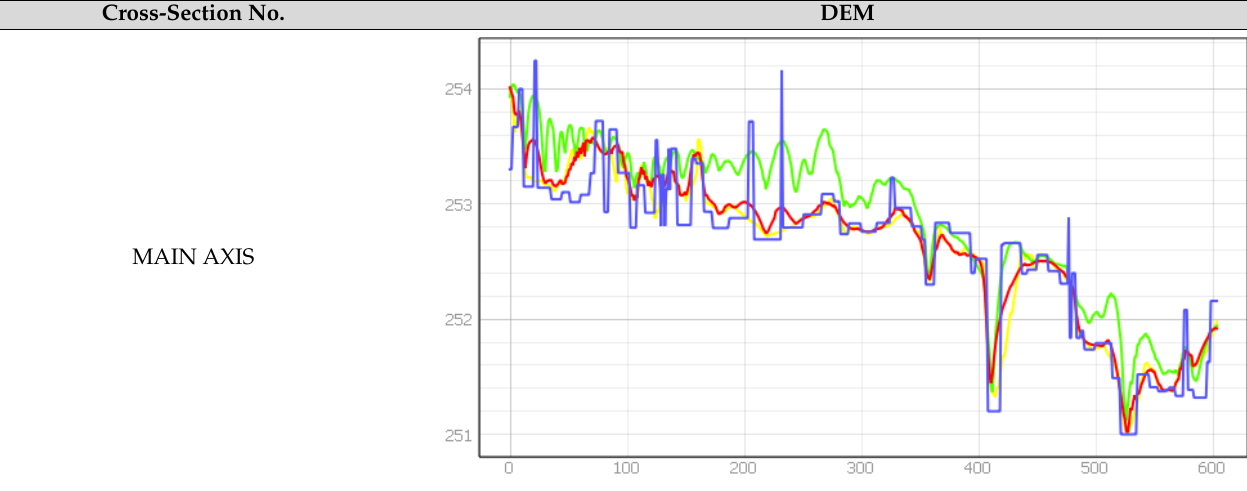
Table 4. Cross-sections of the watercourse bed on the DEM and DSM in raster form; source: own